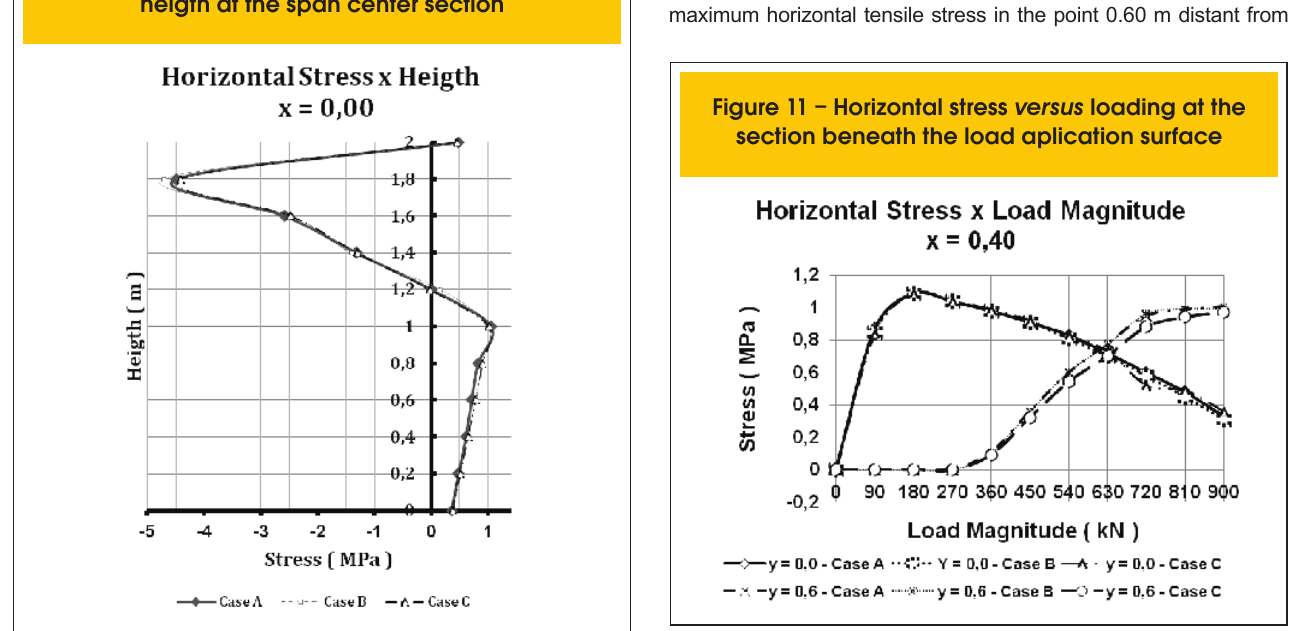
Figure 9 – Horizontal stress versus heigth at the span center section